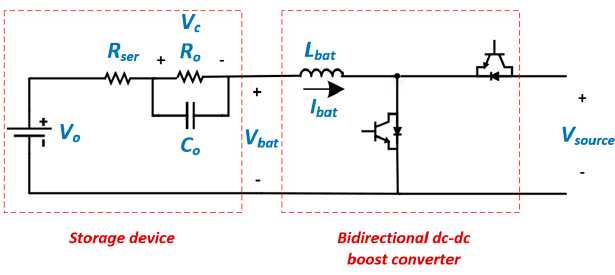
Figure 1. The entire DC distribution system.